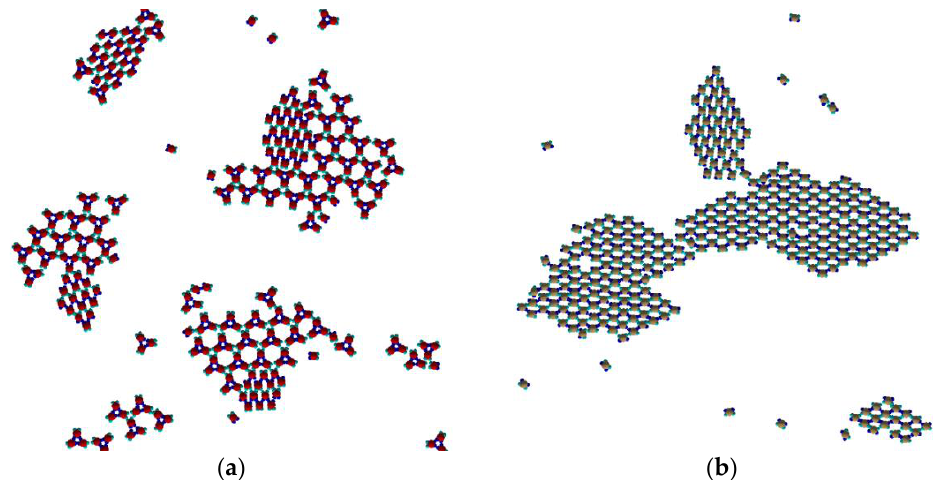
Figure 5. MC simulations at T* = 0.10 of pure PPs type I and PPs type II, with number density of 0.20: ( a ) metastable Rh and stable Kagome phase of PPs type I in time interval of their co-existence, for details see [31]; At prolonged simulation times only the Kagome phase survives. ( b ) (meta)stable Rh phase of PPs type II only. This is the only phase solely formed by this type of PPs.